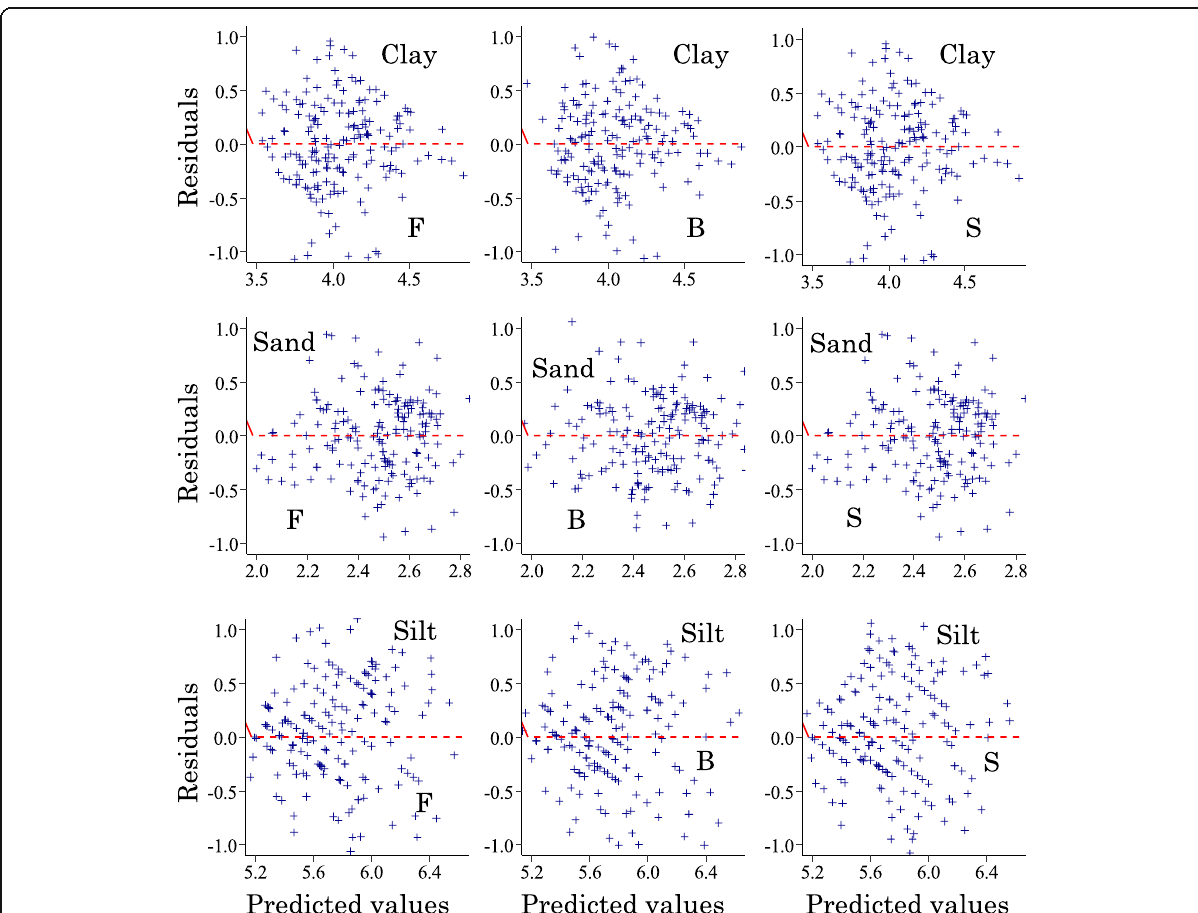
Fig. 2 Residuals plots of multiple linear regression models applying forward (F) selection, backward (B) elimination, and stepwise (S) selection